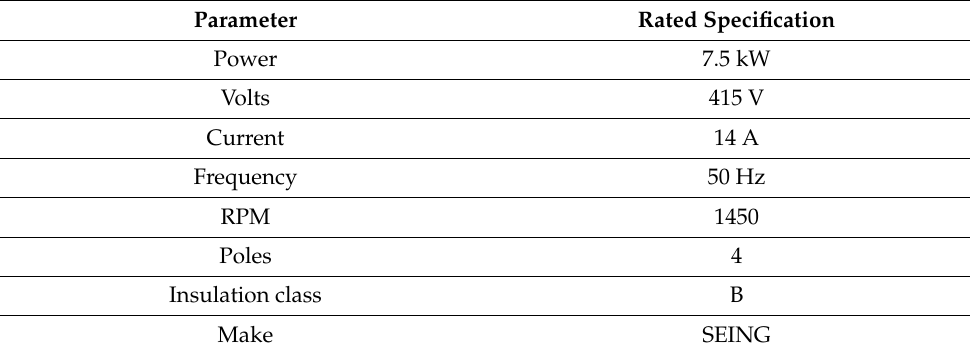
Table 1. Technical specifications of hydraulic pump